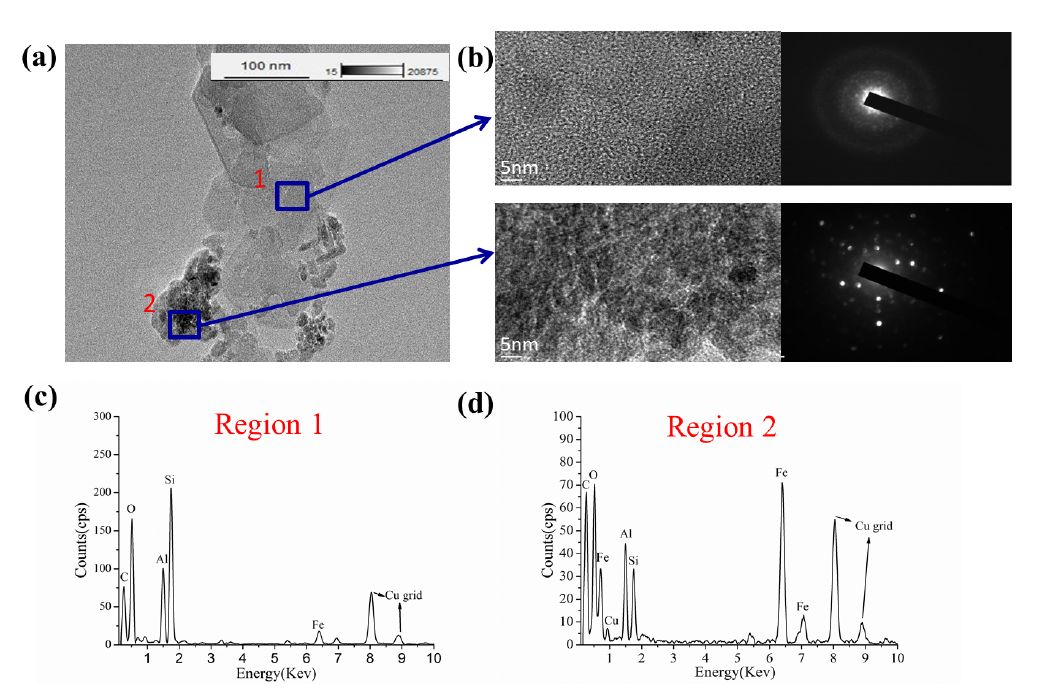
∗ Note:control,nofertilization;NPK,chemicalnitrogen,phosphorus,andpotassiumfertilization;NPKM,chemicalNPKplusswinemanurefertilization,SOM,soilorganicmatter.Al XPS andFe XPS indicatedthesurfaceconcentrationofAl andFeinsoilcolloids,whichweredeterminedbytheX-rayphotoelectronspectroscopy(XPS).Al o andFe o indicatedreactiveAlandFenanominerals,whichwereextractedusingacidammoniumoxalate.DOC,dissolvedorganiccarbonin soilcolloids.Short-rangeordered(SRO)mineralswerecalculatedusingtheformulaofAl